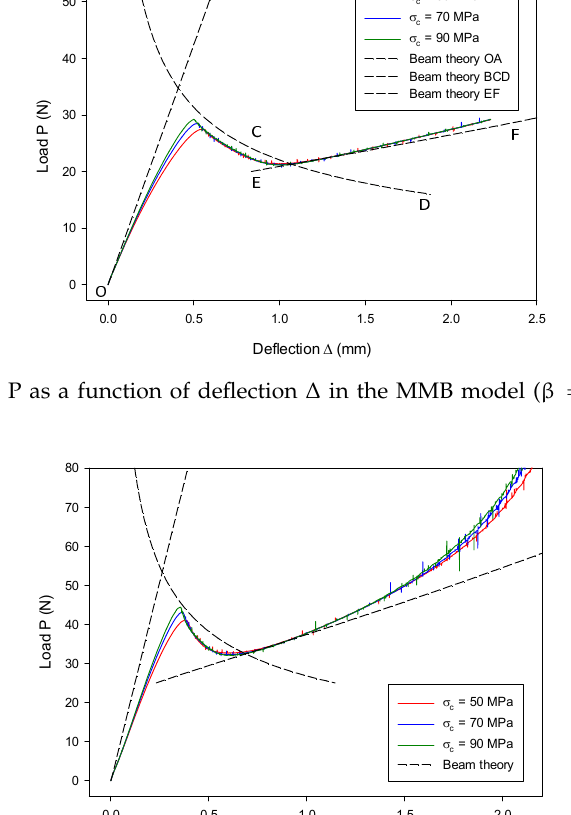
Figure 25. End load P as a function of deflection ∆ in the MMB model ( β = 80%) with different cohesive strengths.